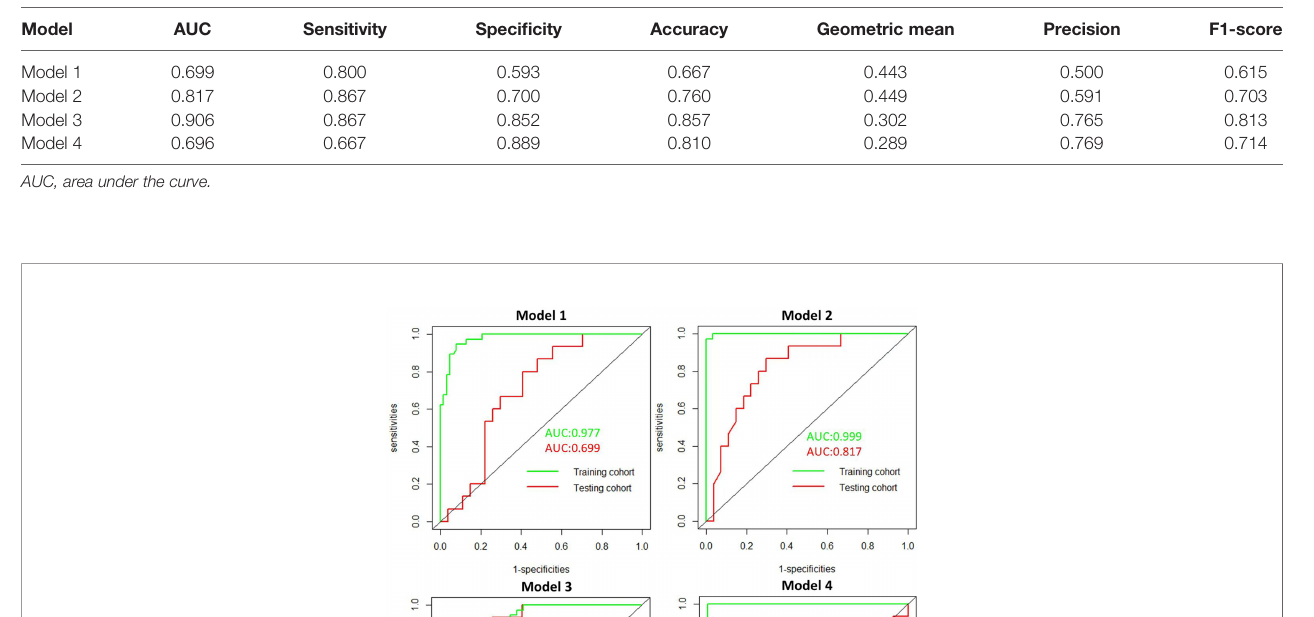
TABLE 3 | Performance of the 3 models in the testing cohort.